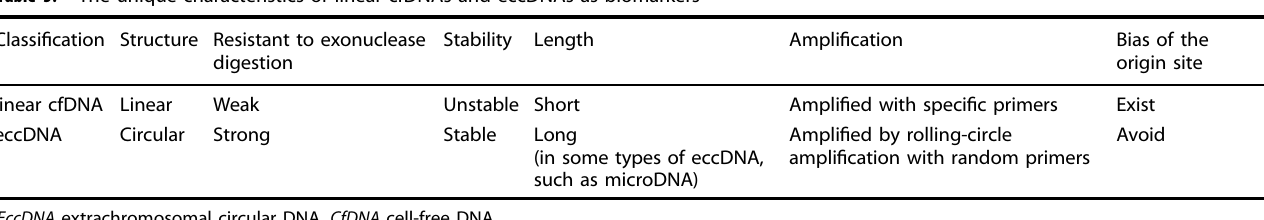
Table 5. The unique characteristics of linear cfDNAs and eccDNAs as